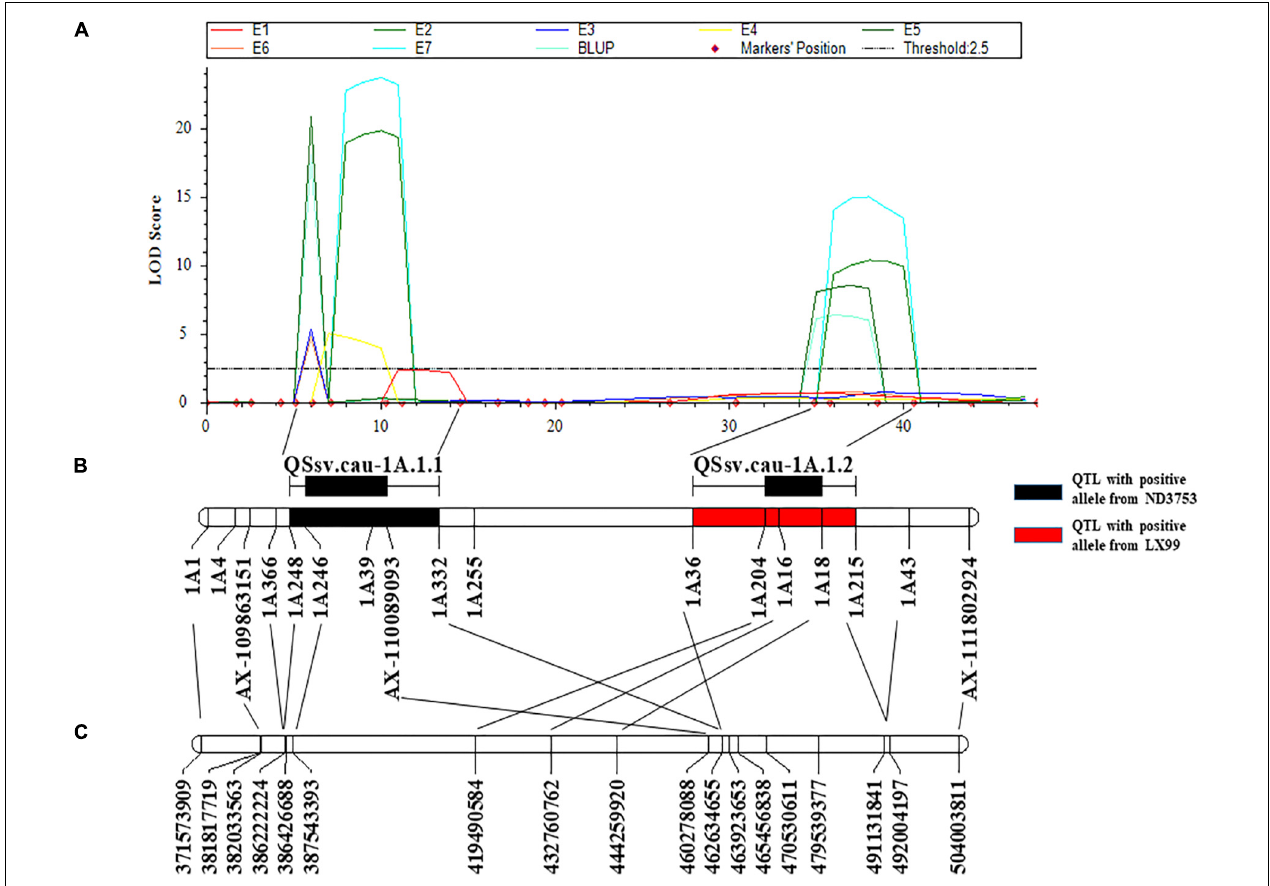
FIGURE 2 | Genetic and physical locations of QSsv.cau-1A.1.1 and QSsv.cau-1A.1.2 . (A) QTL mapping for SSV in seven individual environments (E1–E7) and BLUP using a saturated genetic map of chromosome arm 1AL. (B) Saturated genetic map of chromosome arm 1AL with newly integrated InDel markers in the DH population. The black and red rectangles indicate QTLs with positive alleles from the parent ND3753 and the parent LX99, respectively. The black horizontal lines and bars above the genetic map represent the confidence interval of the two QTLs. (C) Corresponding physical positions according to the Chinese Spring IWGSC RefSeq v1.0